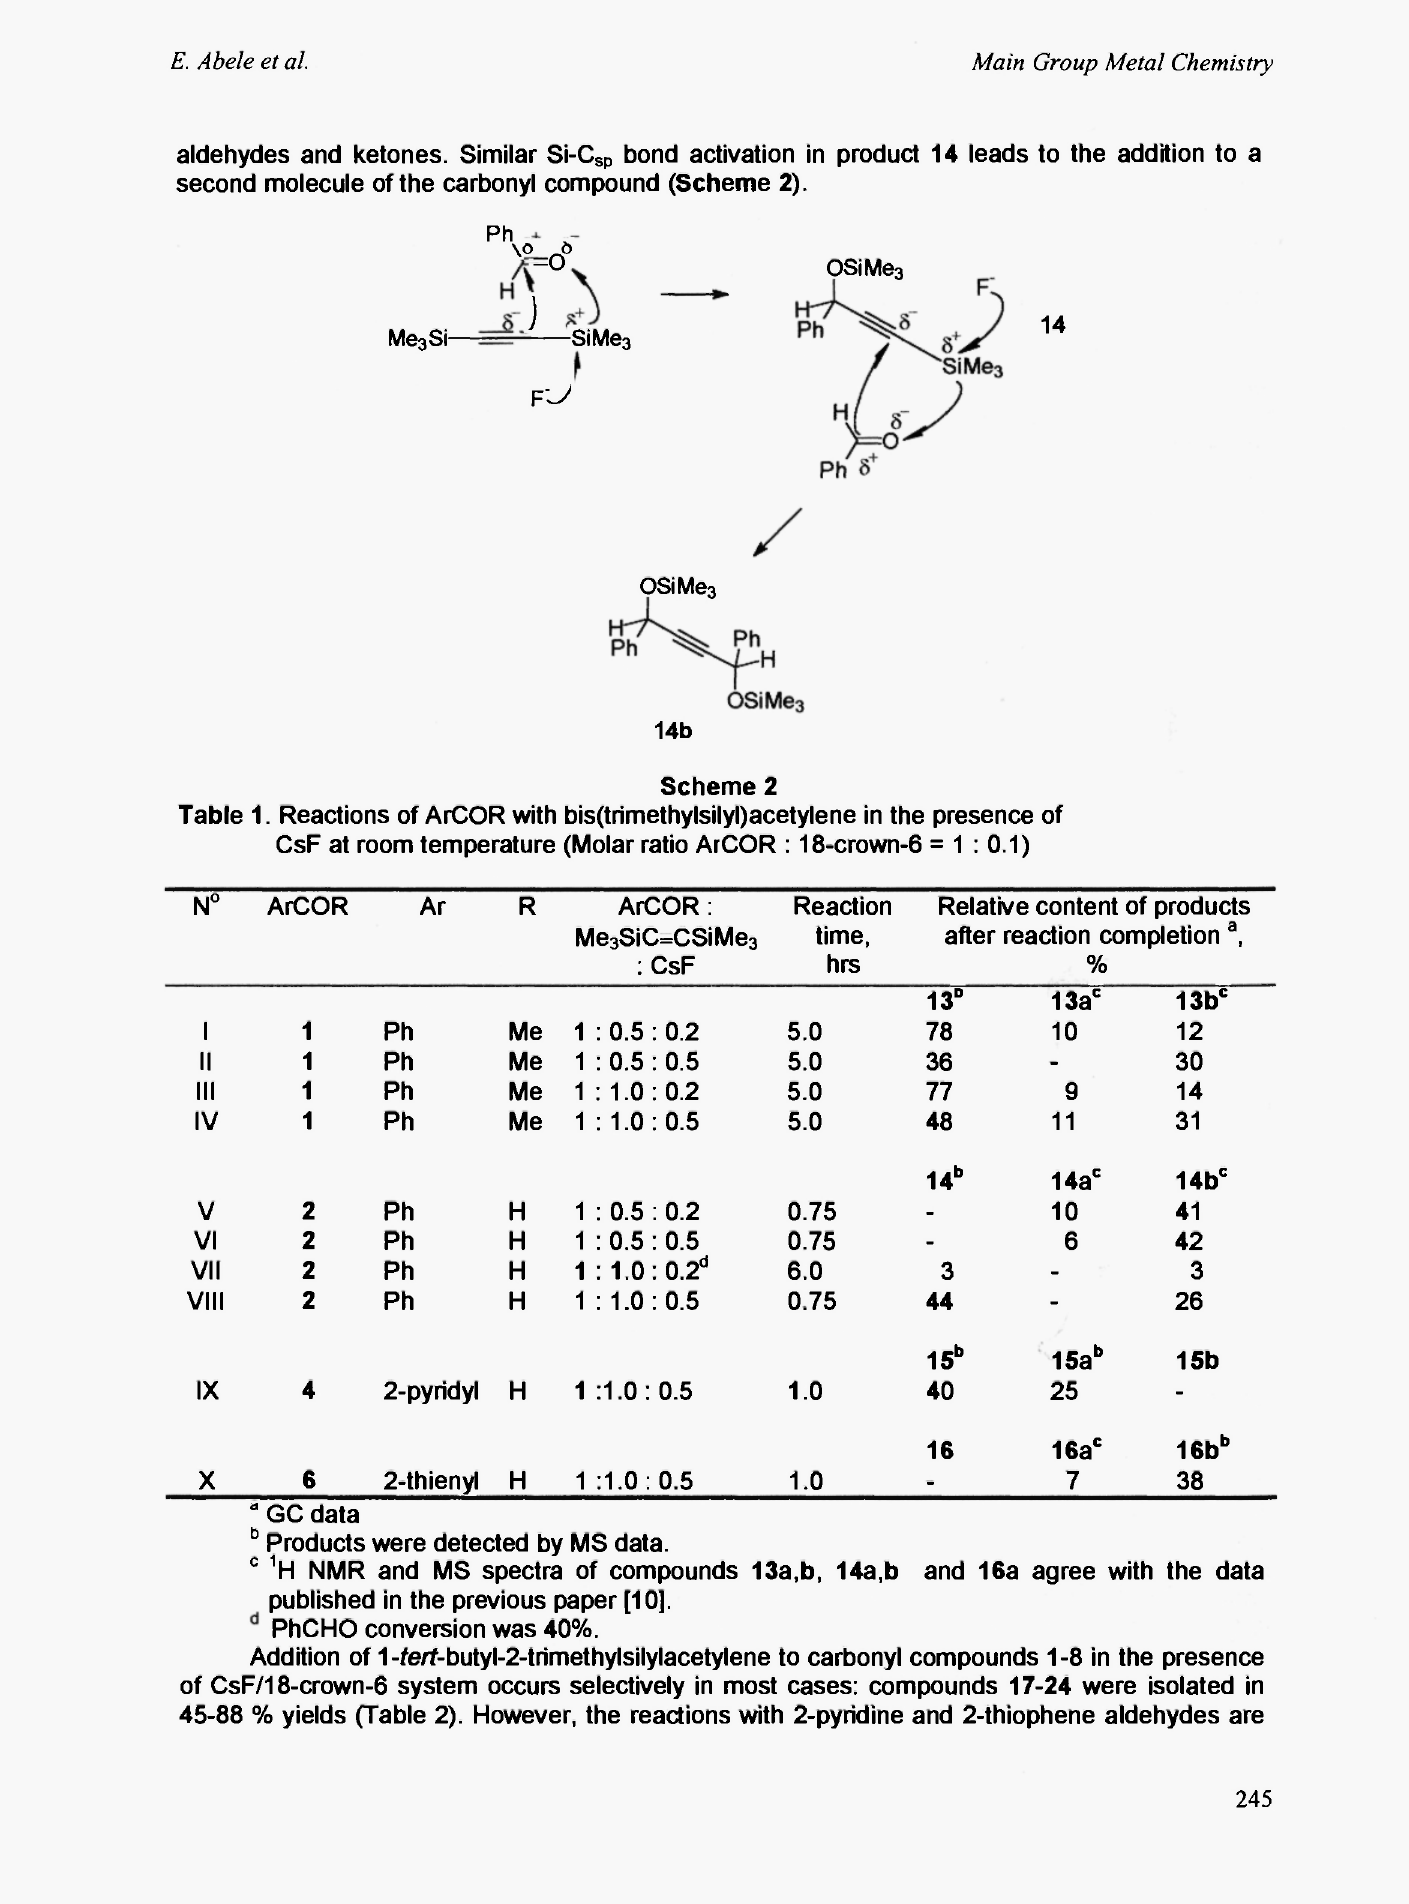
" GC data b Products were detected by MS